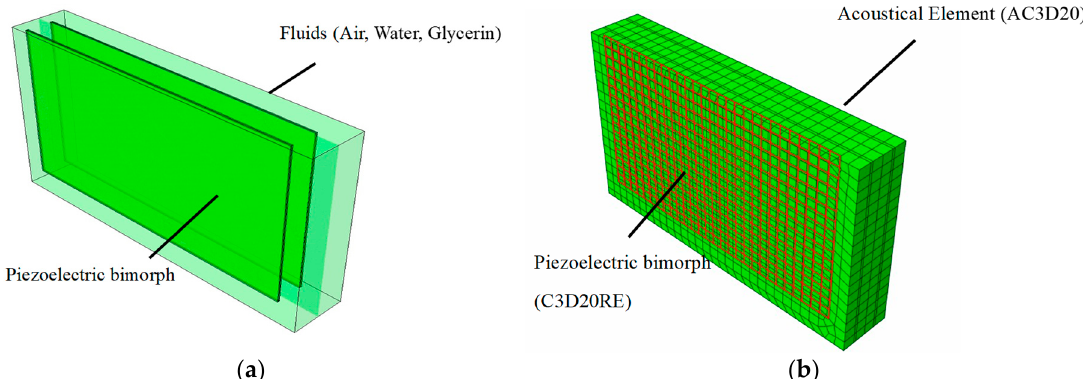
Figure 5. Finite element model of proposed piezoelectric pumping element: ( a ) immersed region as shown in transparent, and ( b ) element types.